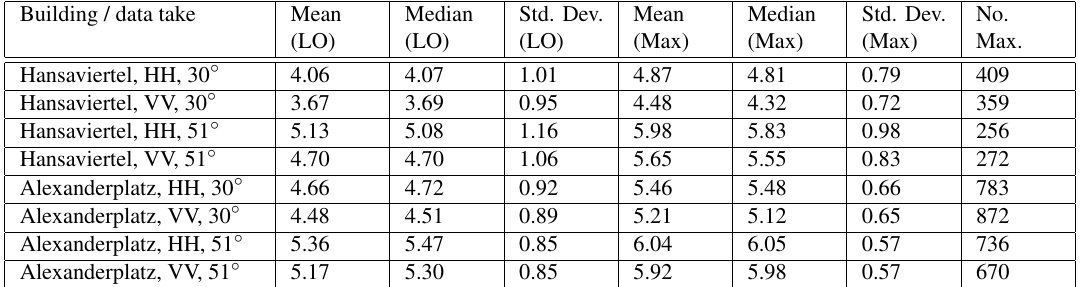
Table 1. Summary of layover properties. LO = layover, Max = local maxima, No. Max. = number of maxima with intensity above mean layover